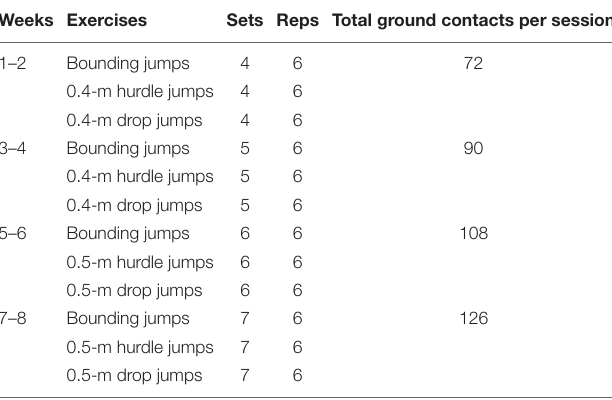
TABLE 2 | Plyometric training program.